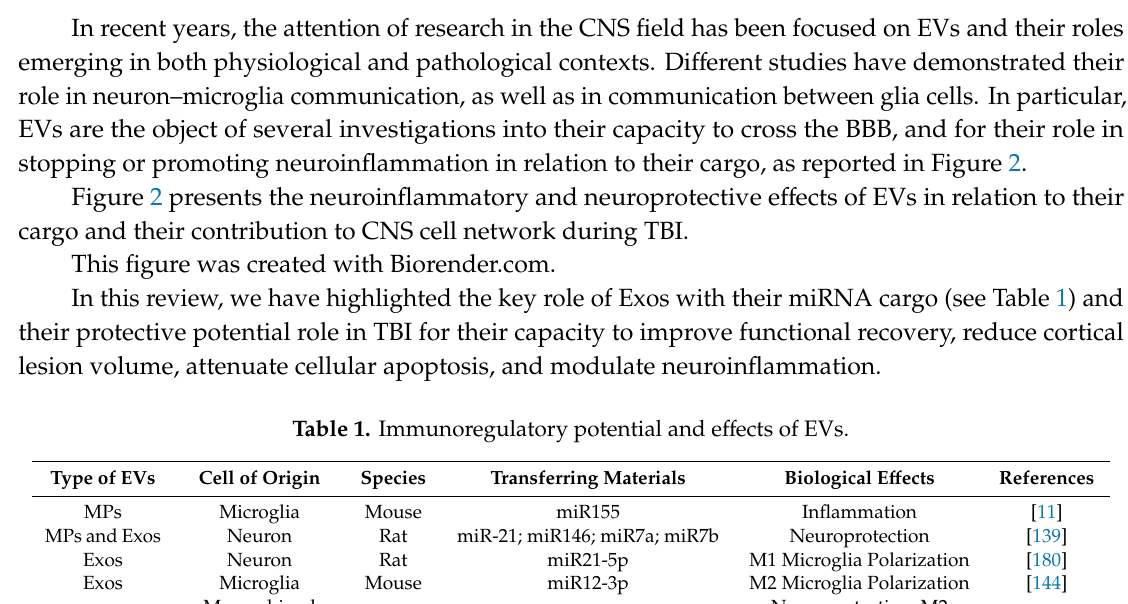
Figure 2. Schematic representation of the effects of EVs in Traumatic Brain Injury.